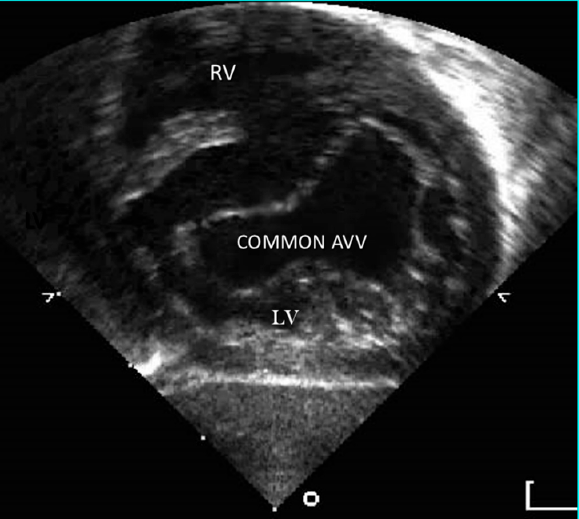
Figure 14. Subcostal left oblique echocardiographic section at the level of the atrioventricular junction showing the common atrioventricular valve committed entirely to the left ventricle.